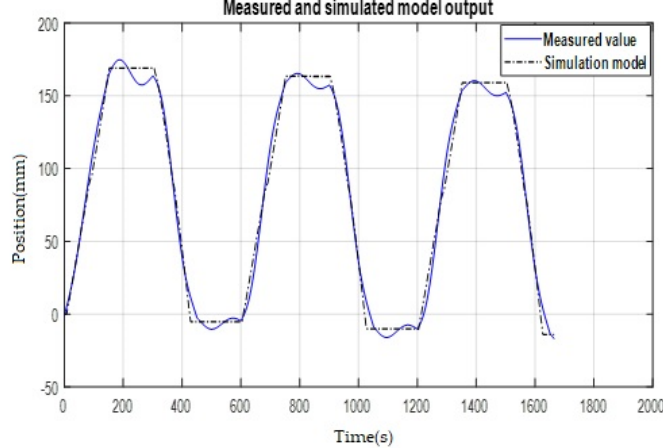
Figure 4. The measured and simulated model output.